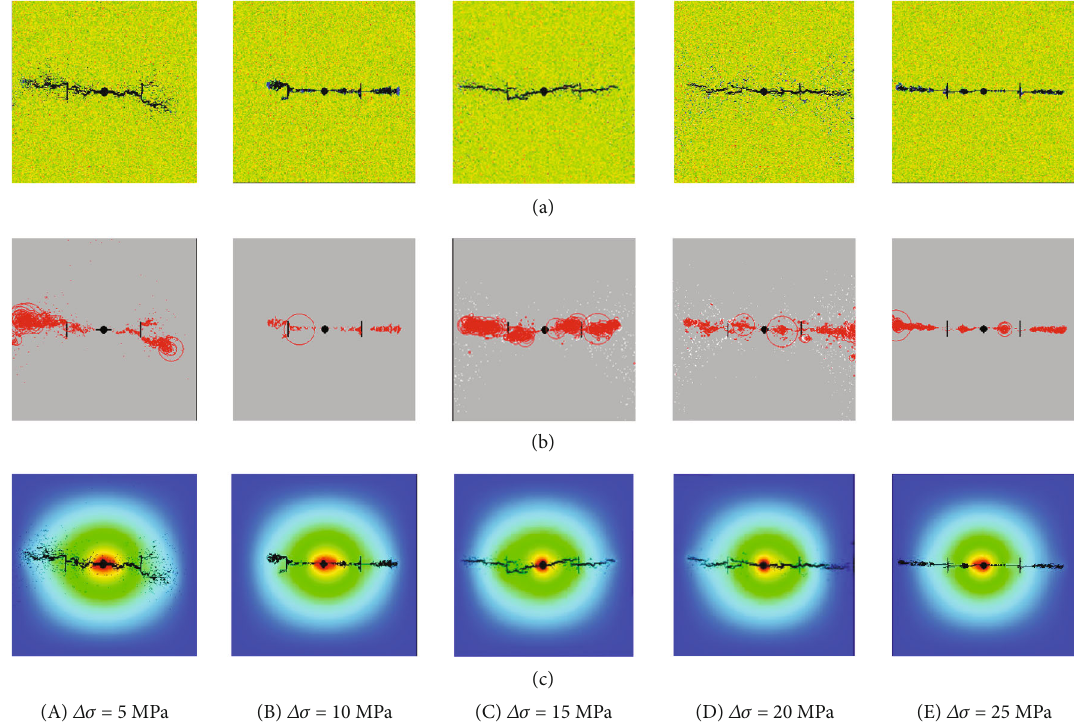
Figure 7: Process of hydraulic fracture propagation under di ff erent horizontal principle stress di ff erences △ σ . (a) Morphology of the hydraulic fracture propagation. (b) Acoustic emission signal. (c) Cloud map of the pore water